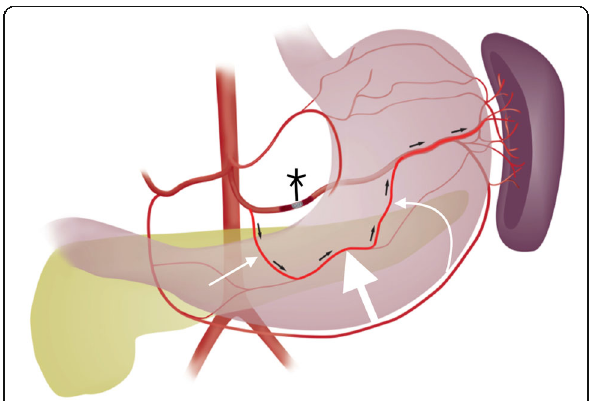
Fig. 5 Schematic for the dorsal pancreatic (thin white arrow) to transverse pancreatic (thick white arrow) to great pancreatic artery (curved white arrow). Short black arrows denote the direction of flow. (Black star-coils in proximal splenic